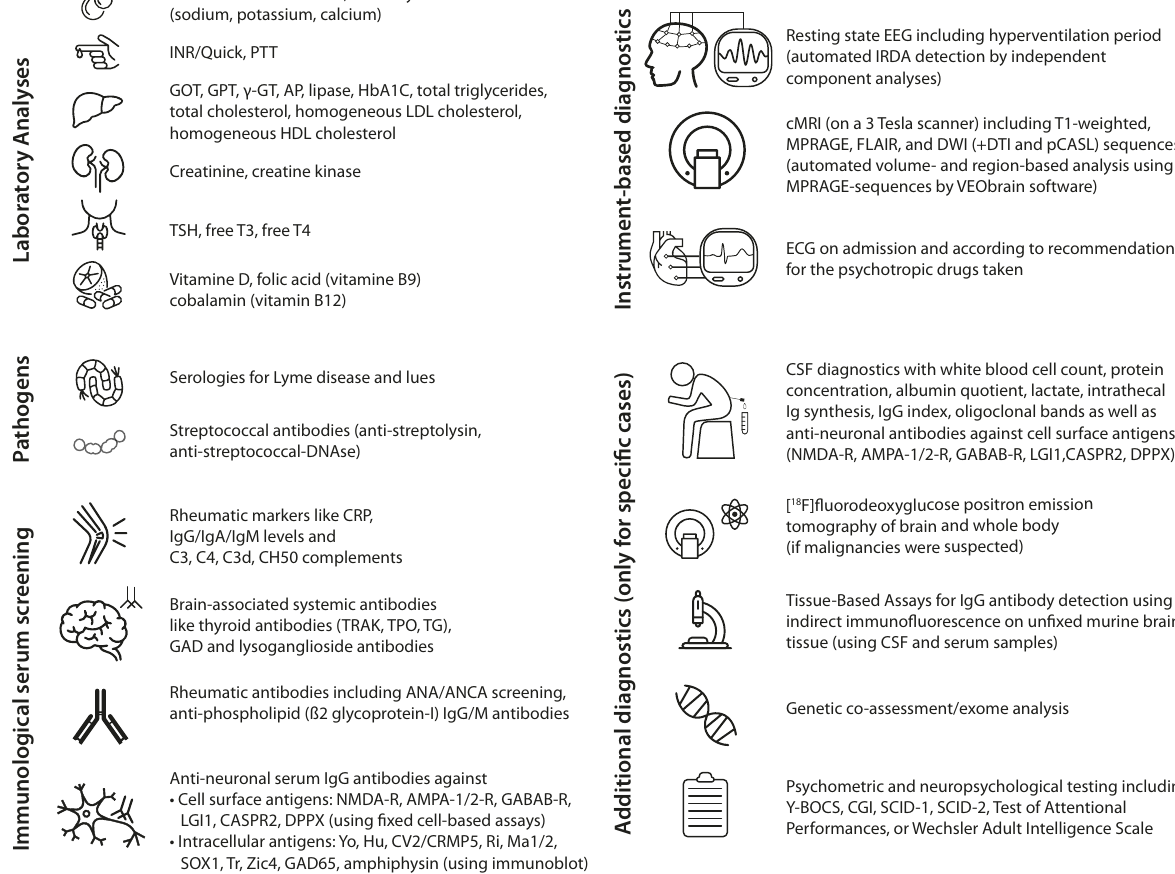
Fig. 1 Freiburg diagnostic protocol for patients with OCD (FDP-OCD). AMPA α -amino-3-hydroxy-5-methyl-4-isoxazolepropionic acid, ANA antinuclear antibody, ANCA antineutrophil cytoplasmic antibody, AP alkaline phosphatase, C3/C4/C3d complement component 3/4/3d, CASPR2 Contactin-associated protein-like 2, CGI Clinical Global Impression, CK Creatine kinase, CH50 complement hemolytic activity, CSF Cerebrospinal fl uid, cMRI cranial magnetic resonance imaging, CRP C-reactive protein, CRMP5 collapsing response-mediator protein-5, DNAse Deoxyribonuclease, DPPX dipeptidyl-peptidase – like protein 6, DTI Diffusion tensor imaging, DWI Diffusion-weighted imaging, ECG electrocardiogram, EEG Electroencephalogram, FDG-PET fl uorodeoxyglucose - positron emission tomography, FLAIR Fluid-attenuated inversion recovery, γ -GT Gamma-glutamyl transferase, GABA Gamma-aminobutyric acid, GAD glutamic acid decarboxylase, GOT Glutamic- Oxaloacetic transaminase, GPT Glutamic-Pyruvic transaminase, HbA1c Hemoglobin A1c, HDL high-density lipoprotein, IgA Immunoglobulin A, IgG Immunoglobulin G, IgM Immunoglobulin M, INR International normalized ratio, LG1 leucine-rich glioma-inactivated 1, LDL low-density lipoprotein, MPRAGE Magnetization Prepared Rapid Acquisition Gradient Echo, NMDA N-methyl-D-aspartate, PCASL pseudo-continuous arterial spin labeling, PTT Partial thromboplastin time, R Receptor, SCID-1/2 Structured Clinical Interview for DSM-IV, T3 Triiodothyronine, T4 Thyroxine, TG Thyroglobulin, TPO Thyroid peroxidase, TRAKs Thyroid-stimulating hormone-receptor-antibodies, TSH Thyroid-stimulating hormone, Y-BOCS Yale-Brown Obsessive Compulsive Scale, Zic4 zinc- fi nger protein